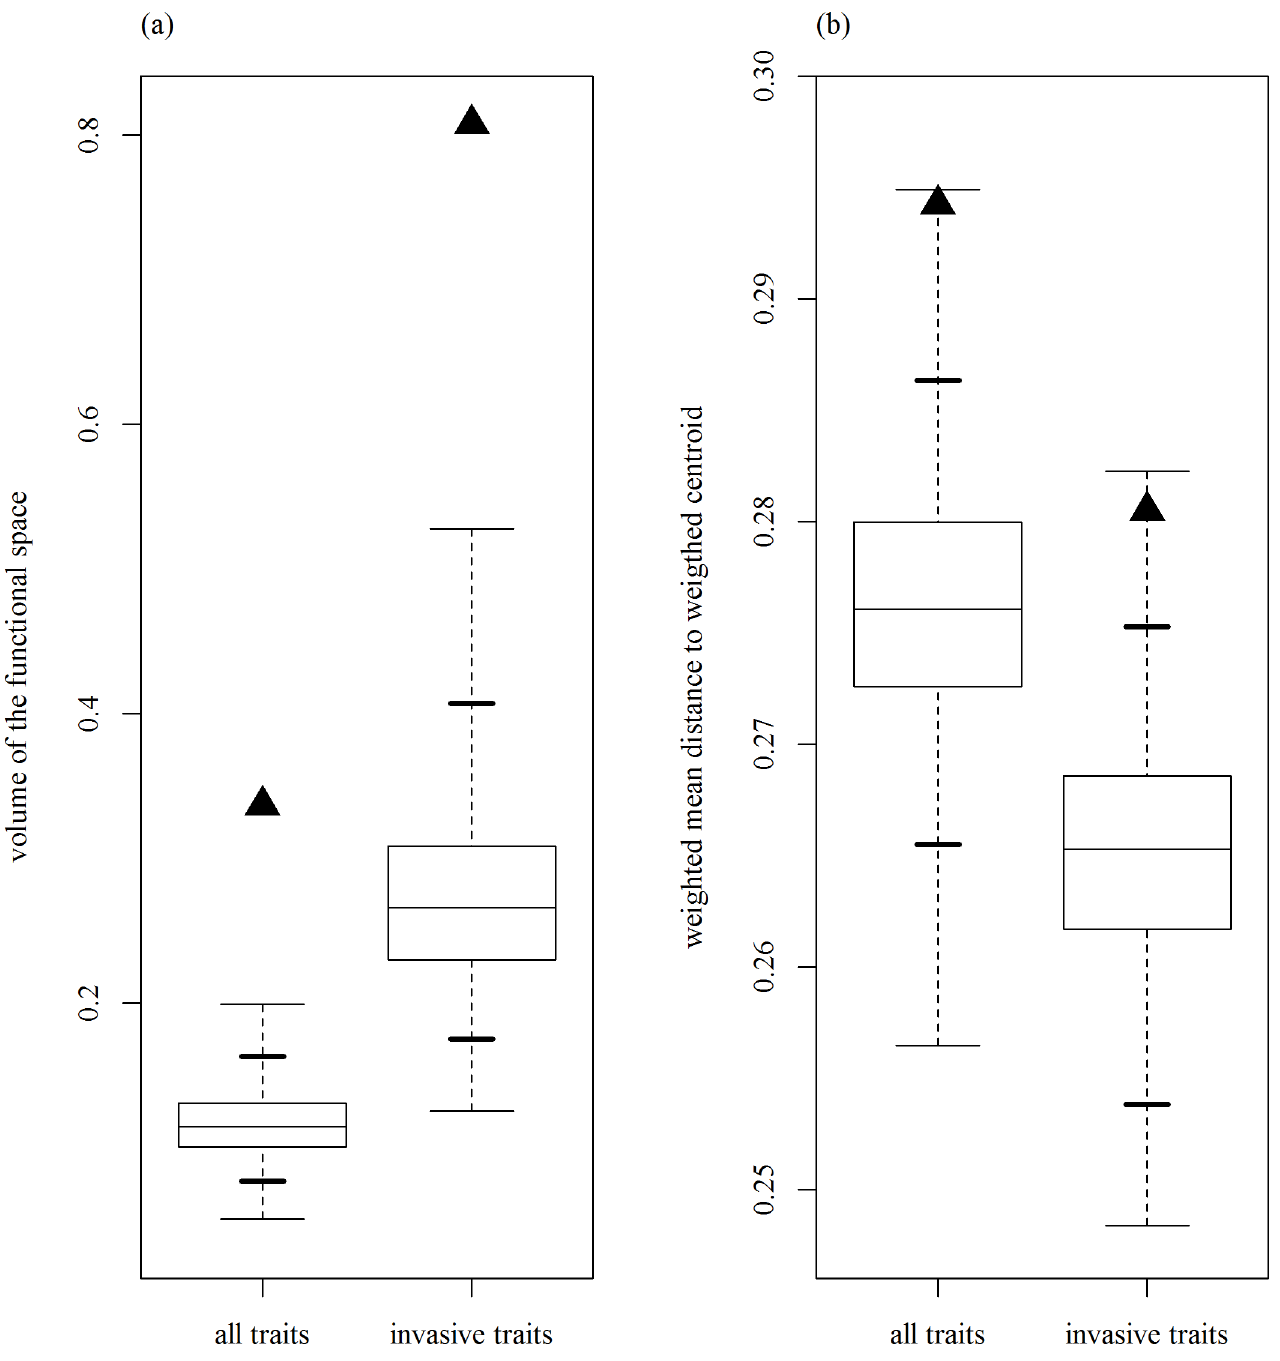
Fig 1. Comparison of functional diversity indices among Austrian plants that are either invasive or not invasive elsewhere in the world. Black triangles symbolize the diversity index values calculated for the group of the 305 invasive plants. The boxplots represent the range of index values calculated for 1000 equally large re-samples from the whole pool of 1402 native species with the bold lines indicating the 0.95 confidence interval of these re-sample based values. Panel (a) represents results for Functional Richness (defined by the volume of the functional space) and panel (b) results for Functional Dispersion (defined by the mean distance in multidimensional trait space of individual species to the centroid of all species), respectively. Label ‘ all traits ’ give results calculated with the total set of collected traits, label ‘ invasive traits ’ calculations based on traits that proved useful to distinguish invasive and non-invasive species in the preceding